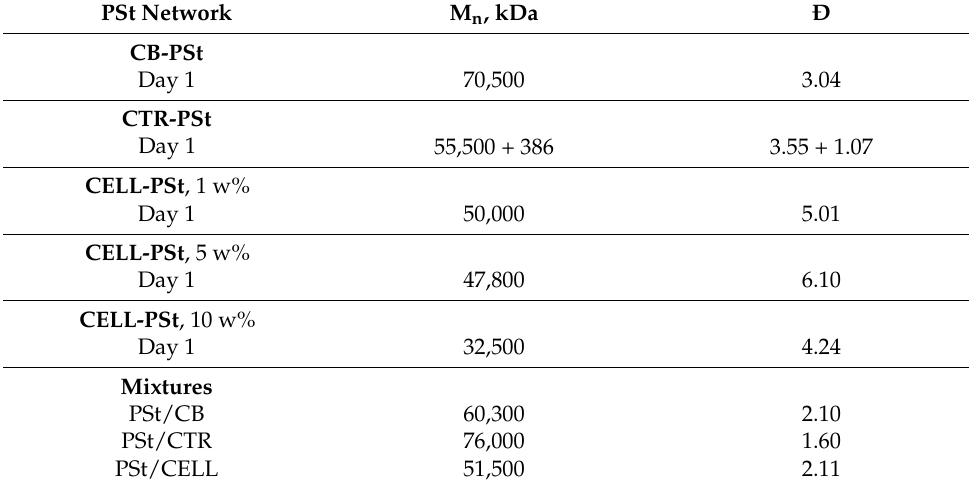
Table 3. Molecular mass and dispersity index (Ð) of non-crosslinked PSt fractions extracted from cellobiose-m (CB-PSt), cellotriose-m (CTR-PSt), cellulose-m (CELL-PSt) gels and of PSt polymerized in a presence of a non-modified carbohydrate